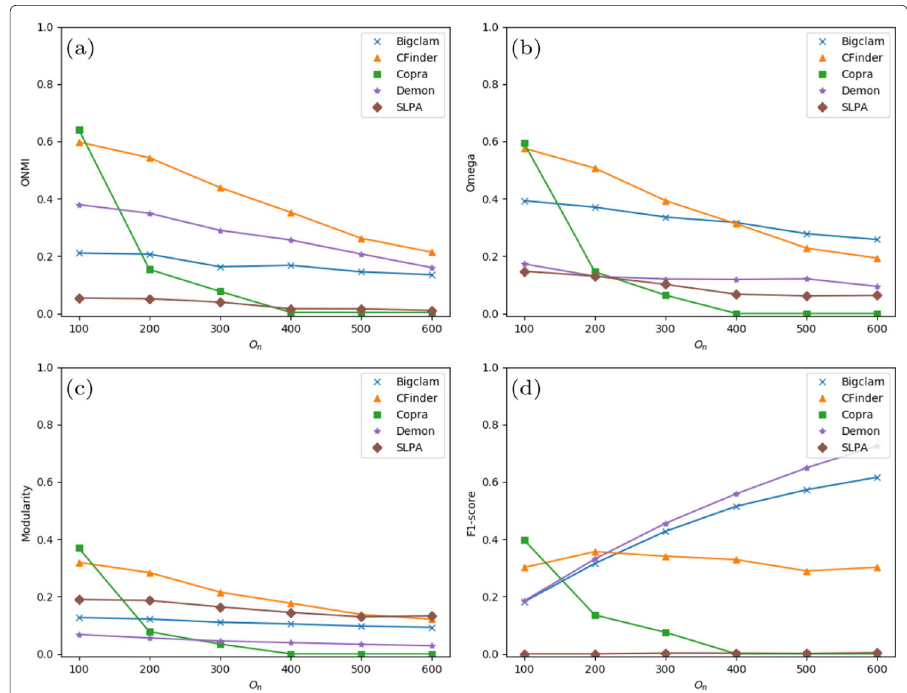
Fig. 11 Variation of the number of nodes in the overlapping region ( O n ) for LFR synthetic networks considering: a ONMI; b Omega; c Modularity and d